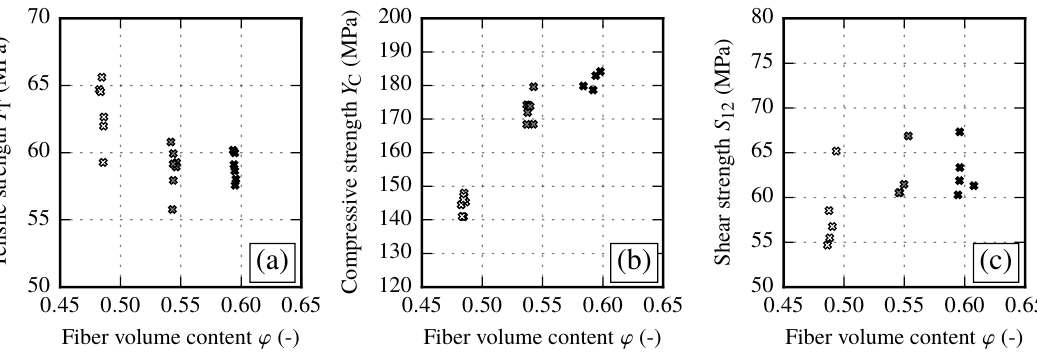
Figure 9. Reference samples—tensile and compressive strength in transverse direction Y T ( a ) and Y C ( b ); and shear strength S 12 ( c ) from V-notch rail shear tests according to ASTM 7078 vs. the fiber volume